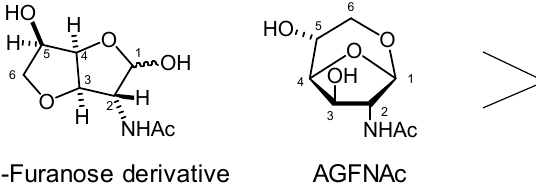
Chart 2. Structural candidates for the product with R f = 0.32.